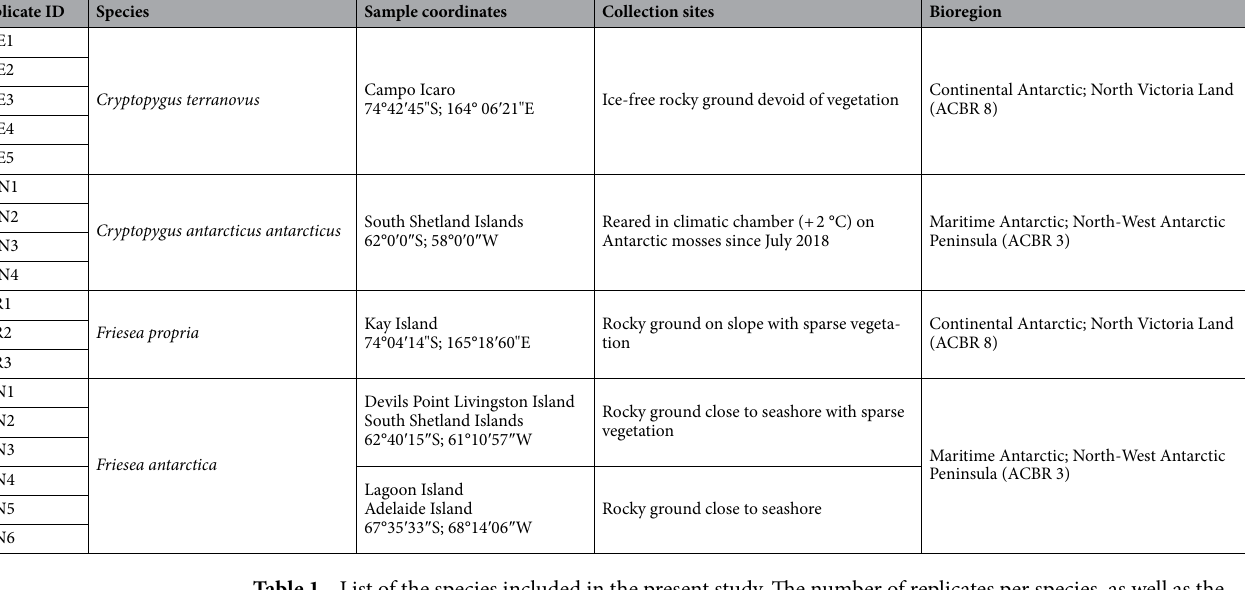
two types of comparisons are made, (1) partitioning samples across “region” (continental Antarctic vs. maritime Antarctic) and (2) across “genera” (i.e., C. terranovus and C. a. antarcticus vs. F. propria and F. antarctica ). DNA extraction and sequencing. Between 15 and 20 animals were pooled, rinsed in 70% ethanol and their DNA extracted using the QIAamp UCP DNA Micro kit (Qiagen, Hilden, Germany) following the manu- facturer’s instructions. A minimum of three replicates for each species and location were included in the study (see Table 1 for details). A first PCR was performed, using primers 341F (5 ′ -CCT ACG GGNGGC WGC AG-3 ′ )